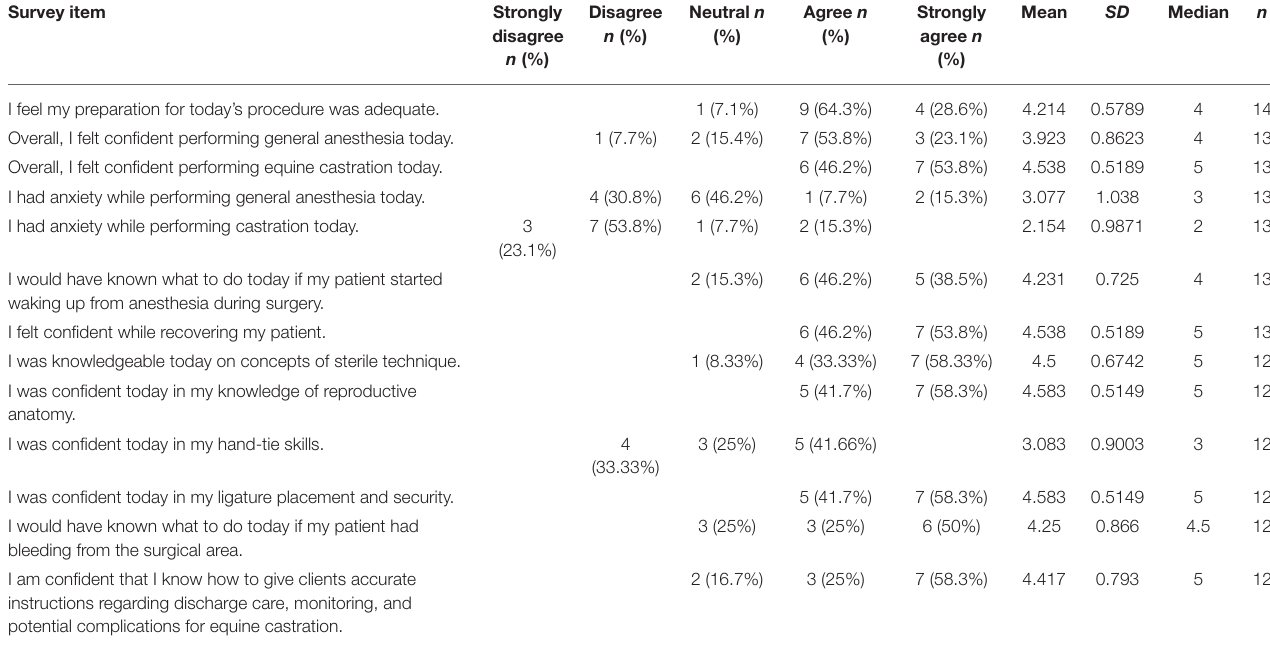
TABLE 7 | Student confidence survey, post-castration, no model experience. Survey